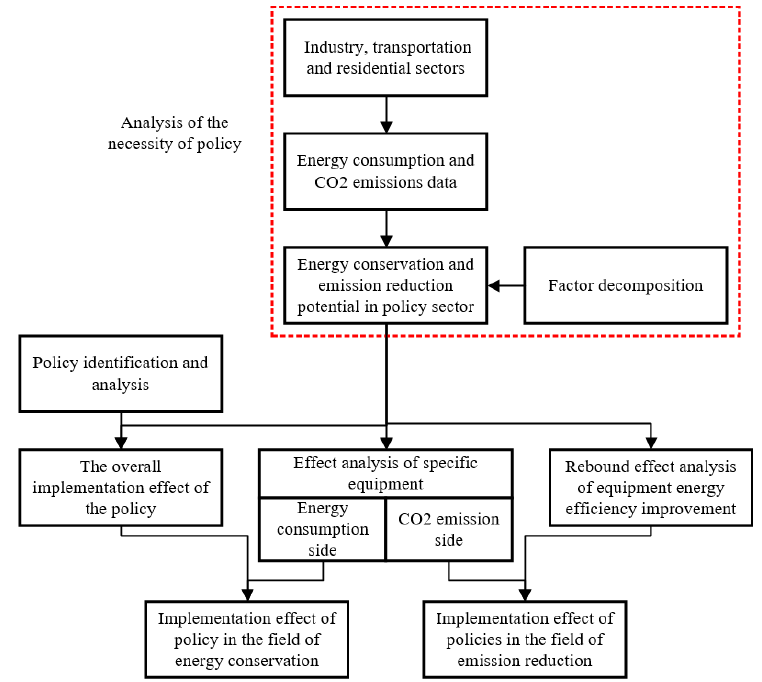
Figure 1. Research flow chart.